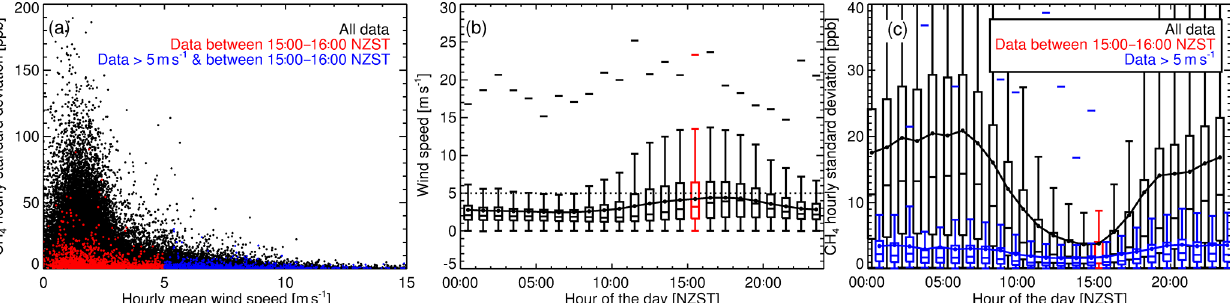
Figure D1. (a) CH 4 hourly standard deviation (minimum of five samples) as a function of wind speed, and data filtered by time of day (red) and full baseline criteria (blue). (b) Box plot statistical summary of hourly wind speed. (c) Box plot statistical summary of CH 4 hourly standard deviation. Note that some of the upper outliers of the box plots are